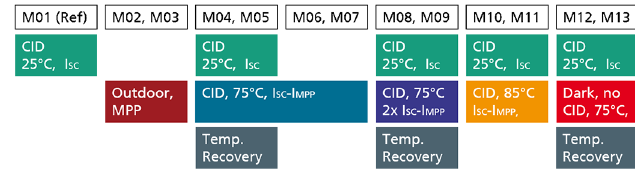
Fig. 2. Overview over